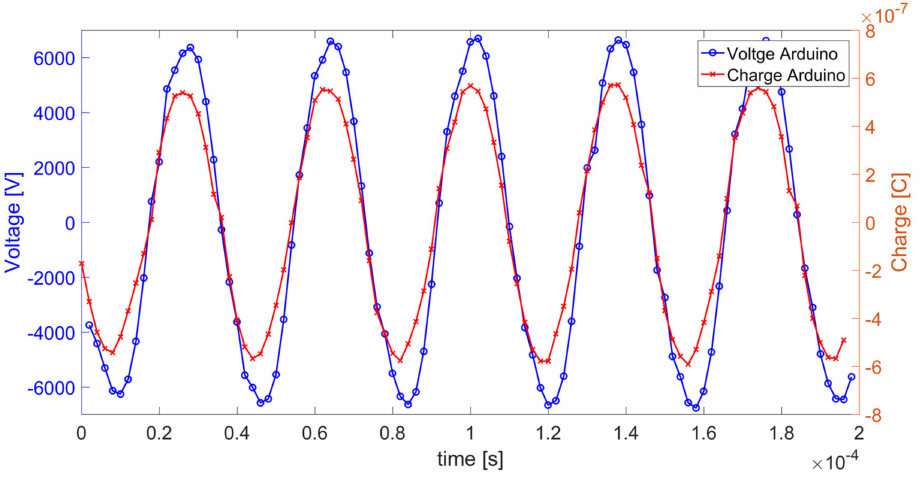
Figure 6. Voltage and charge as functions of time, detected by the micro-controller.